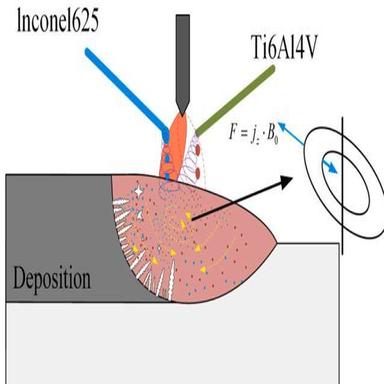
Schematic diagram of the effect of the AC arc on the molten pool.